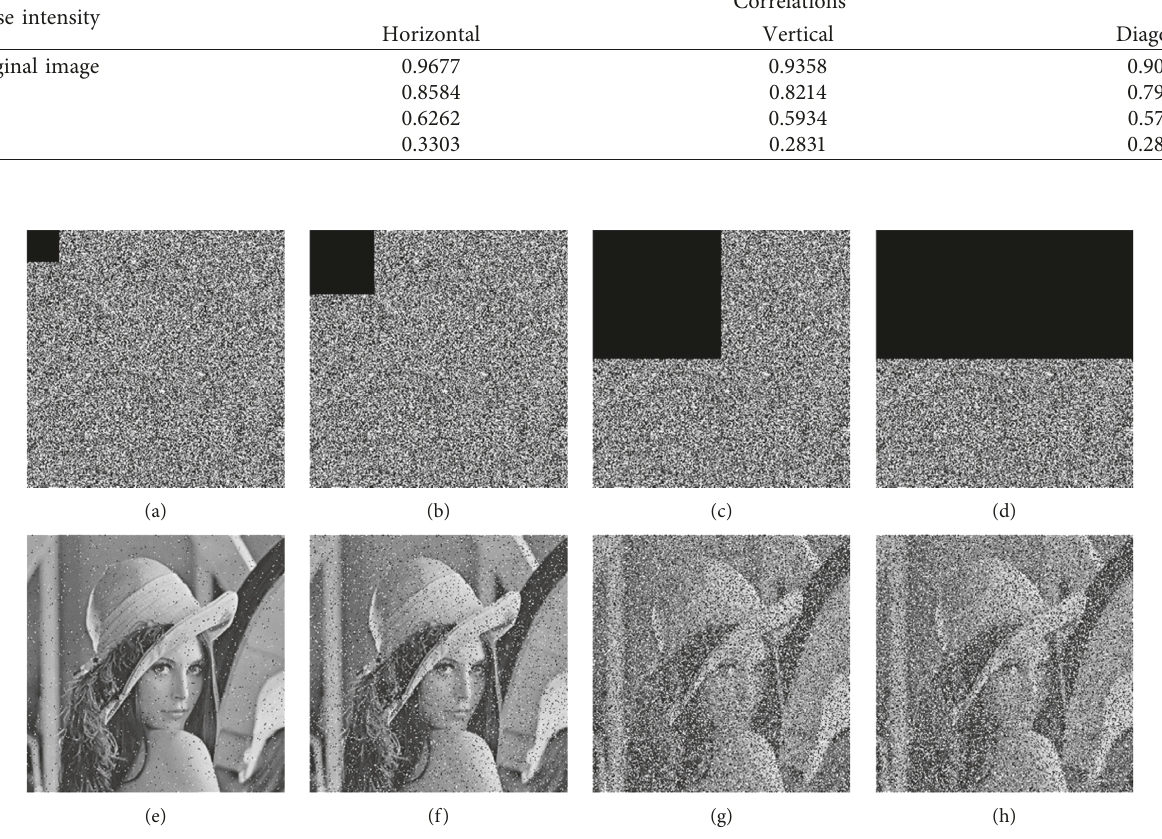
Figure 11: Decrypted images with occlusion attack. (a) Occlusion 1/64. (b) Occlusion 1/16. (c) Occlusion 1/4. (d) Occlusion 1/2. (e) Decrypted image with 1/64 occlusion. (f) Decrypted image with 1/16 occlusion. (g) Decrypted image with 1/4 occlusion. (h) Decrypted image with 1/2